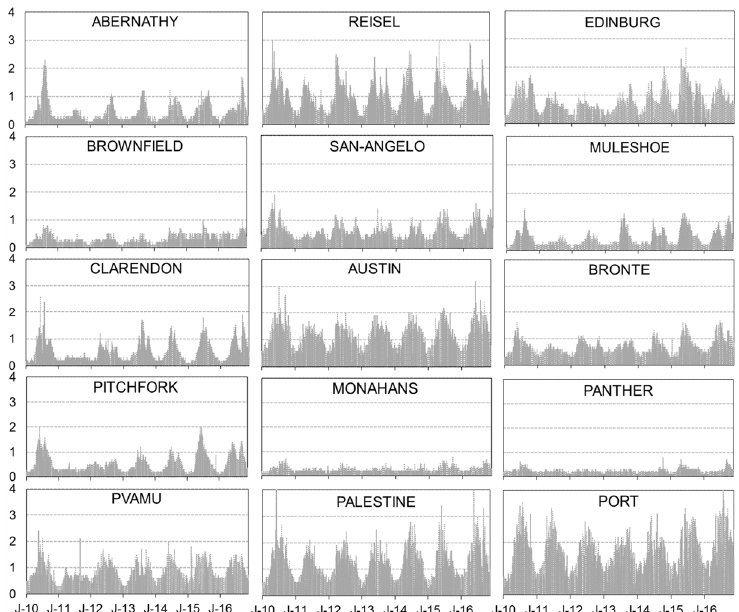
Figure 11. Temporal distributions of Leaf Area Index (LAI) at 15 selected Texas in situ observation stations, shown via MODIS grid.